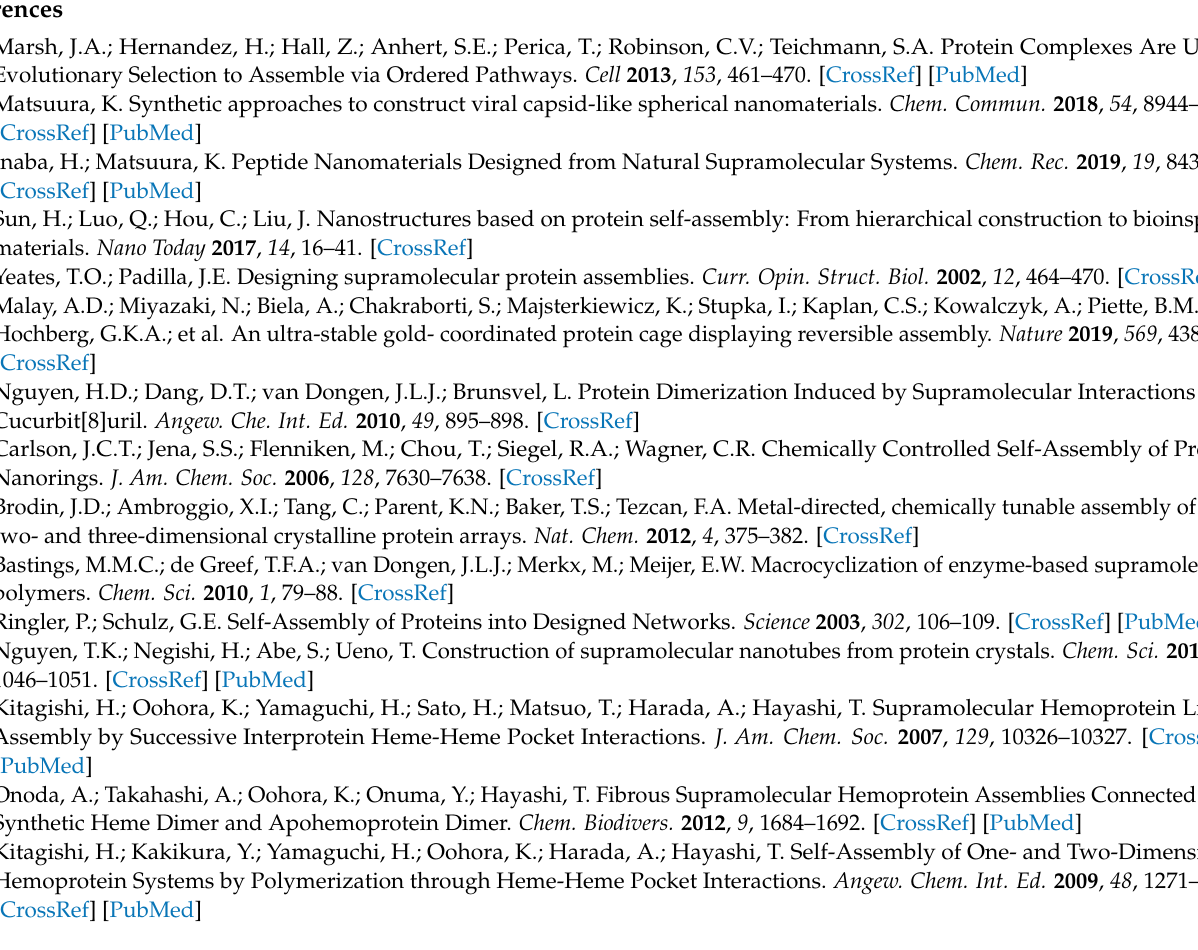
and relationship between band density and 1 -Cyt b 562N80C concentration, Figure S3: Image analysis of SDS-PAGE for assemblies, Table S1: Peak areas of SDS-PAGE bands for various concentration of HTHP, Table S2: Peak areas of SDS-PAGE bands for various concentration of 1 -Cyt b 562N80C , Table S3: Peak areas of SDS-PAGE bands for